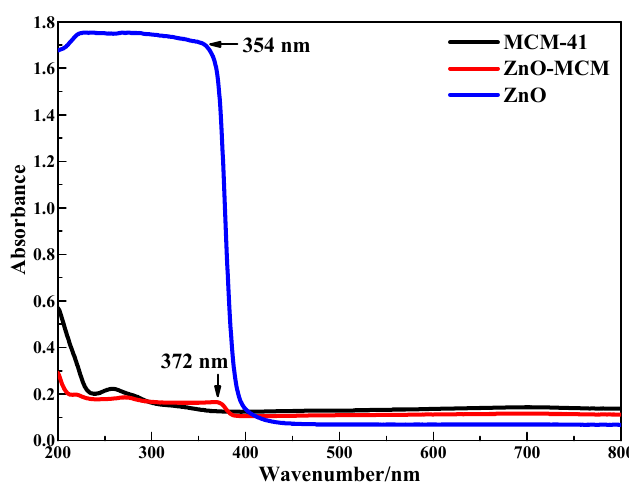
Figure 8. Diffuse reflectance UV-vis spectra of MCM-41, ZnO-MCM, and ZnO.